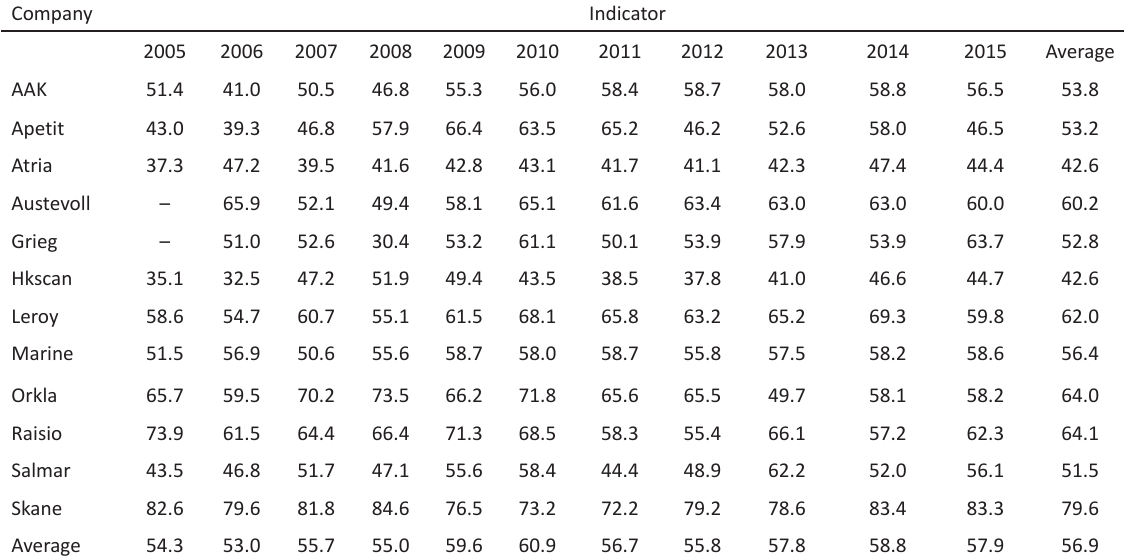
Table 4. The complex indicator (A) of strategies for working capital management of food companies from Northern Europe Company